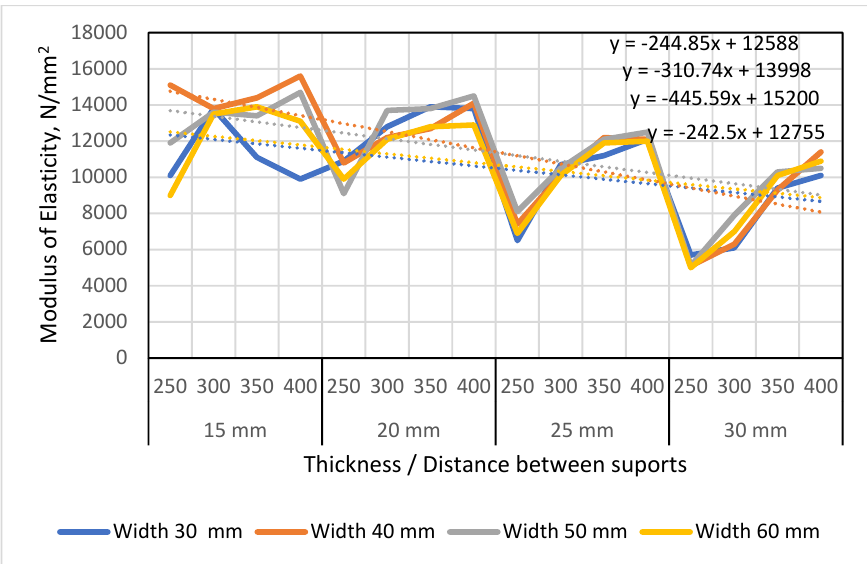
Figure 6. The evolution of the deformation forces until the breaking of the specimen.